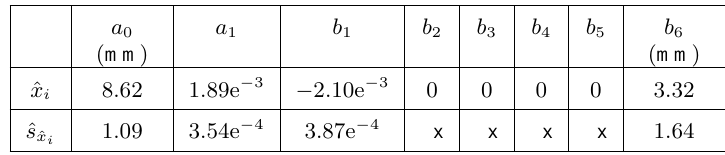
Figure 6: Network geometry: All eight traffic cones and six LSRF positions (represented as fans) are shown, but only a few camera poses for reasons of clarity. The crosses on top as well as the different orientations of the cones additionally ensure a stable network